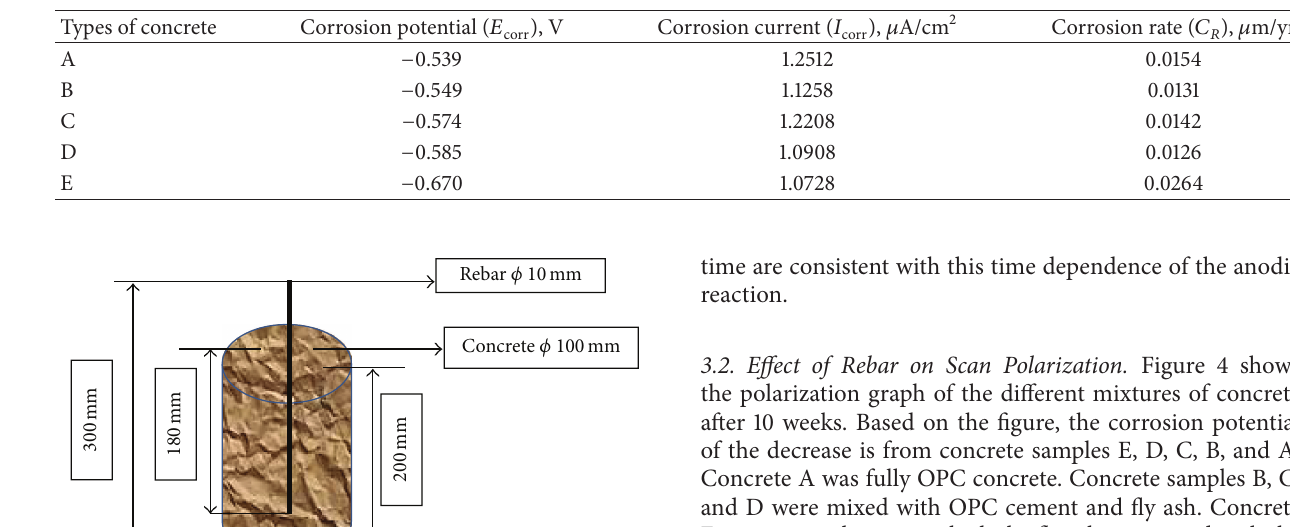
Table 3: Effects of types of concrete on corrosion rate and corrosion potential.